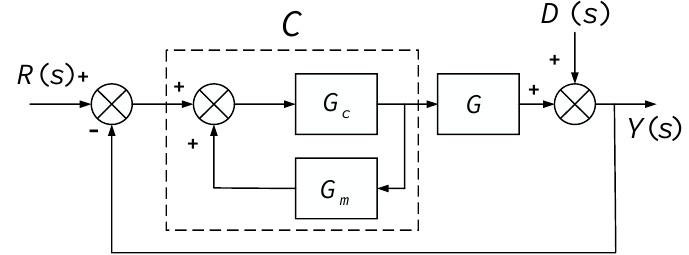
Figure 7. General structure of IMC-PID controller.